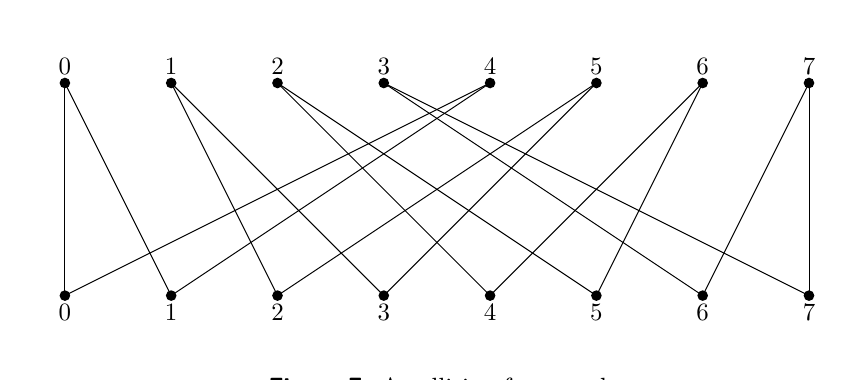
Figure 7: A collision-free graph